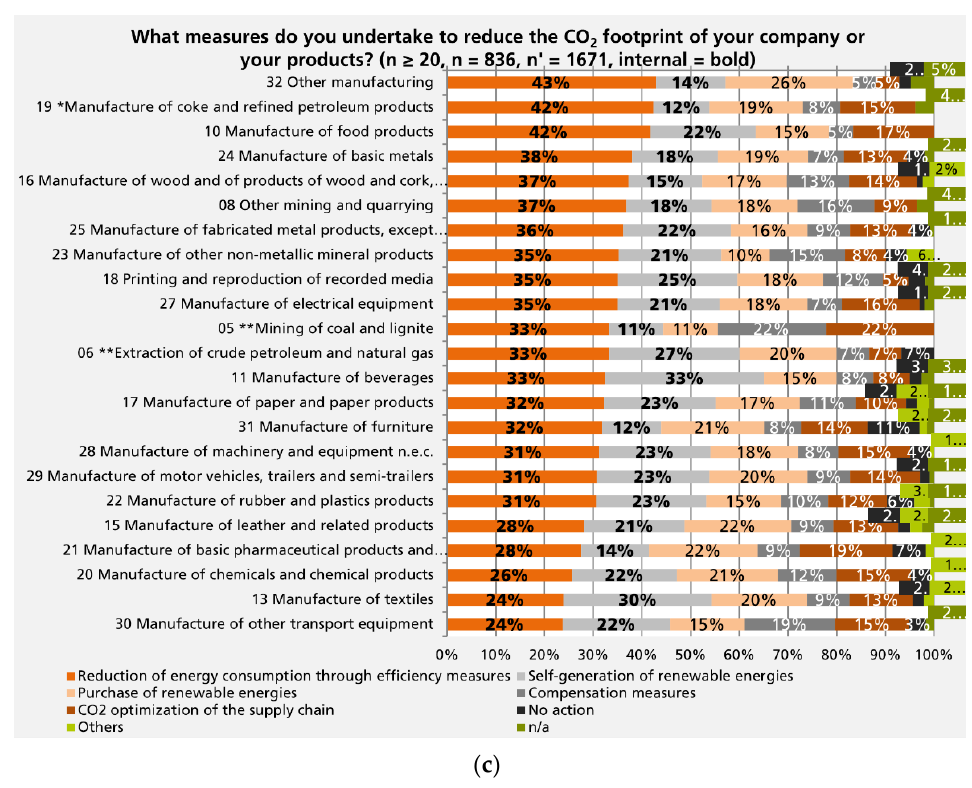
Figure 1. ( a ) Measures undertaken to reduce the CO 2 footprint of a company or products, by company size; ( b ) measures undertaken to reduce the CO 2 footprint of company or products, by energy intensity; and ( c ) measures undertaken to reduce the CO 2 footprint of company or products, by